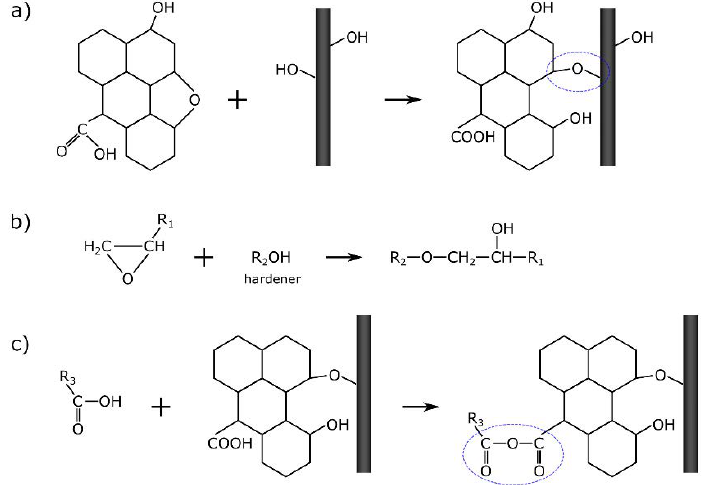
Figure 10. Proposed mechanism of GO influences on the CFRP composite: ( a ) GO to carbon fiber (CF) bonding [32]; ( b ) resin hardening reaction; and ( c ) proposed mechanism of combining fibers with